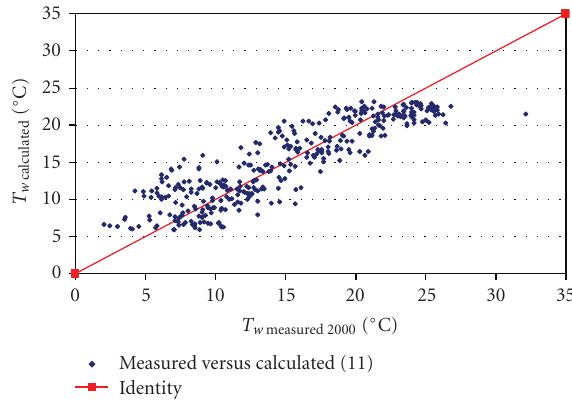
Figure 8: Water temperature values and residuals, experiment with standardization (daily average values).